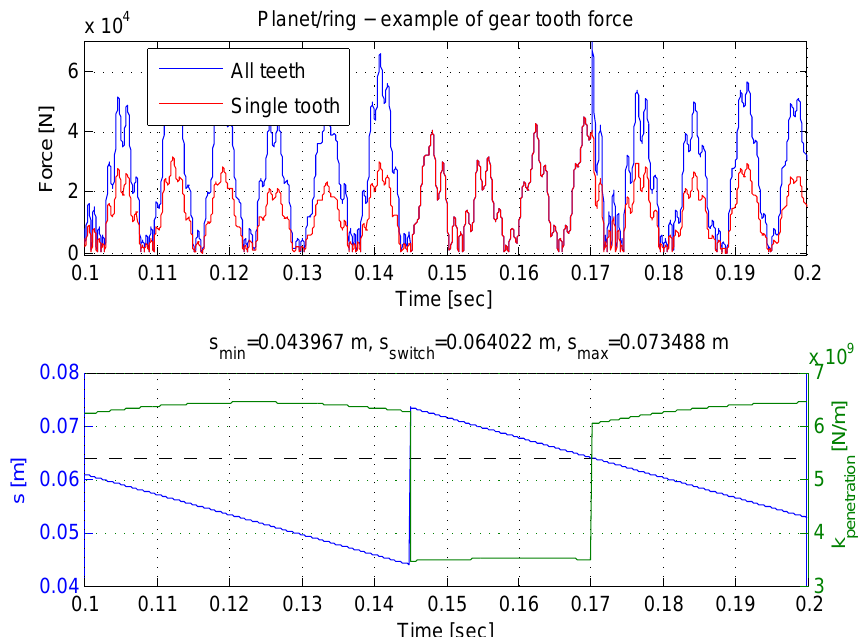
Figure 8: Top graph: The total gear tooth force is shown in blue, while the gear tooth force from a single gear (due to lower sti(cid:27)ness) is shown in red. When only one pair of teeth is in mesh, the red and blue curves are coinciding. The multibody program uses the blue curve, but for the fatigue analysis, the red (single-tooth contact) curve will be used. Lower graph: The base circle arc length of the inner gear ( s 1 on Figure 7b) and corresponding FEM-sti(cid:27)ness. forces (used on the RHS of Equation (5)) as well as a (cid:28)ctive (cid:16)single tooth force(cid:17), including corresponding (lower graph) base circle arc length and tooth sti(cid:27)ness as a function of